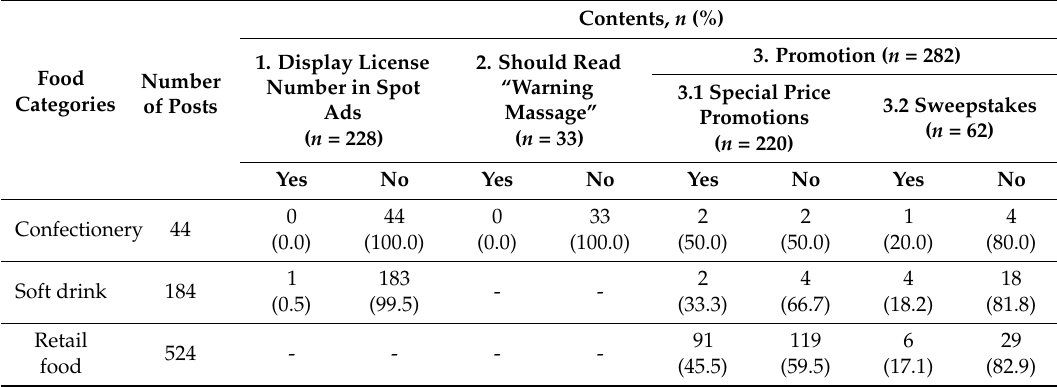
Table 4. Compliance with three government statutory regulations.